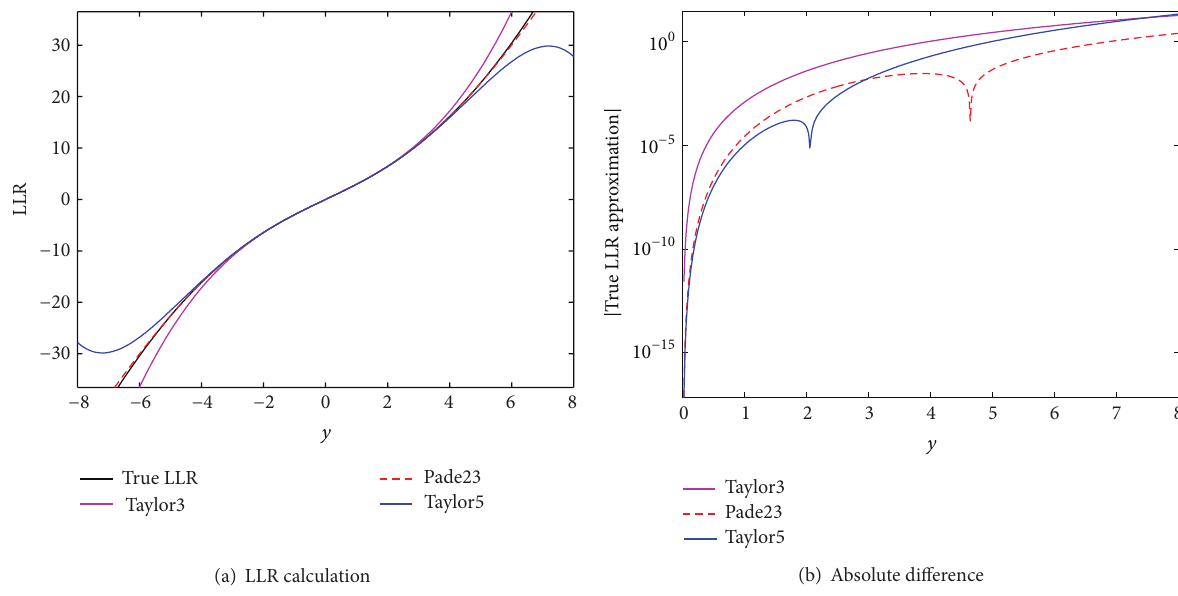
Figure 2: Comparison of true LLR and approximated LLRs (Taylor3, Taylor5, and Pade23) for the uncorrelated flat Rayleigh fading channel with unknown CSI and 𝜎 = 0.6449 . From (a), Pade23 gives nearly the same values as the true function for various channel output 𝑦 , and Taylor5 shows inaccurate as |𝑦| becomes large. From (b), accuracy of Pade23 and Taylor5 is good especially for small |𝑦| . But accuracy of them is different for large |𝑦| ; that is, Pade23 shows the best accuracy in three methods, but Taylor5 shows the worst accuracy.